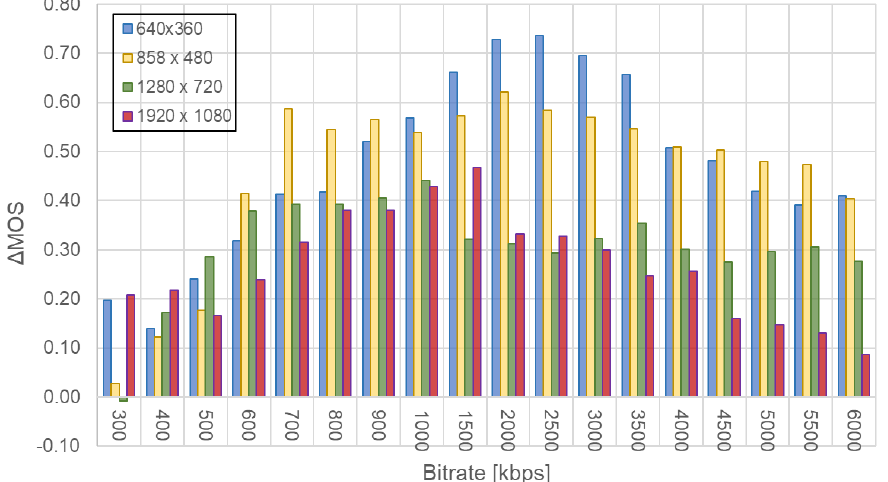
Figure 13. Difference between the results of the subjective evaluation of the VP9-encoded video (ΔMOS), conducted in the laboratory and at home, as a function of bit rate for different resolutions.